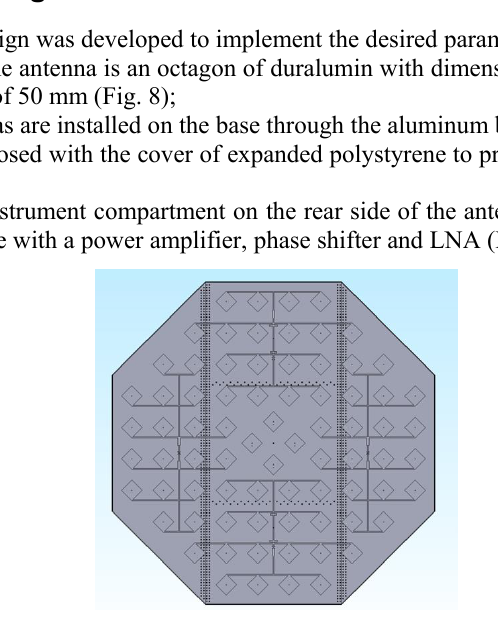
Fig. 8. The appearance of the antenna (top view).